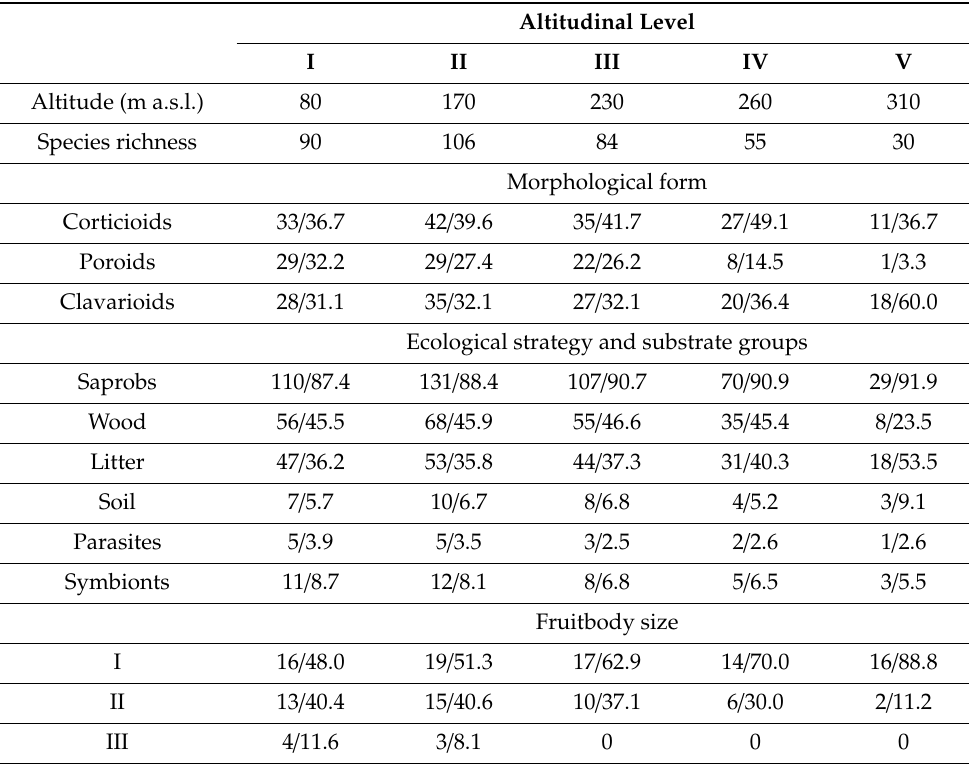
Table 4. Species richness and proportion (%) of aphyllophoroid fungi belonging to di ff erent morphological forms, to di ff erent ecological strategies, having di ff erent substrate preferences or with di ff erent fruitbody size